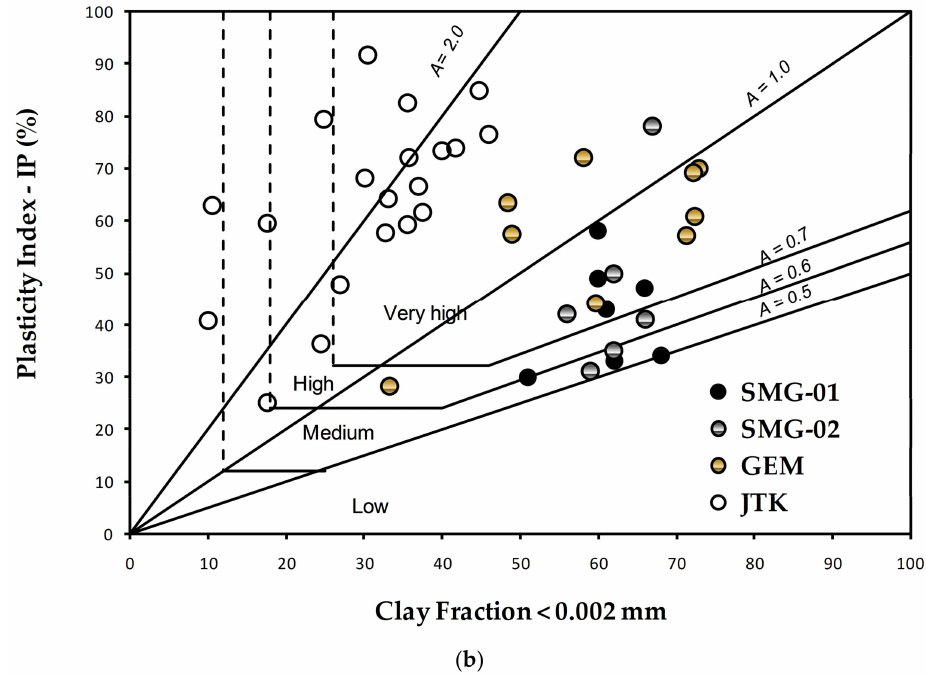
Figure 6. ( a ) Plasticity chart; ( b ) Clay activity chart [modified from 52].